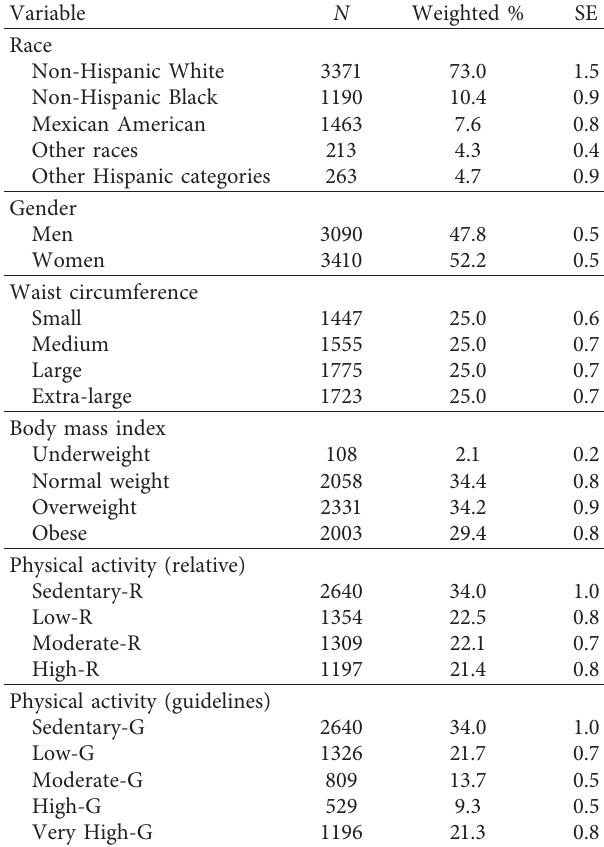
Table 1: Descriptive characteristics of the sample ( n �